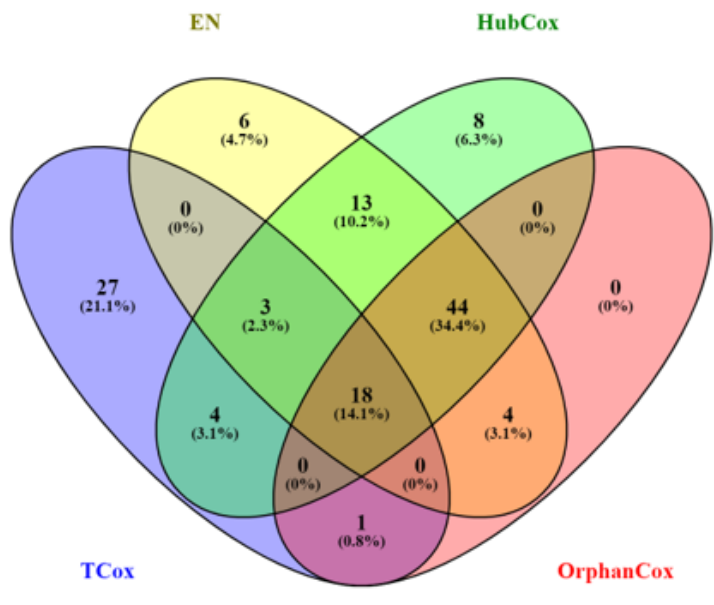
Figure 5. Venn diagram representing the number of genes selected by EN (yellow), HubCox (green), OrphanCox (red), and TCox (blue) using α =